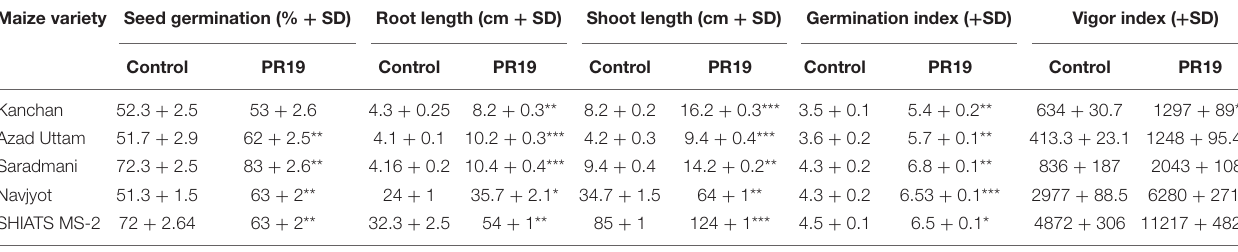
TABLE 6 | Effect of Azotobacter nigricans on growth parameters of different Maize verities.